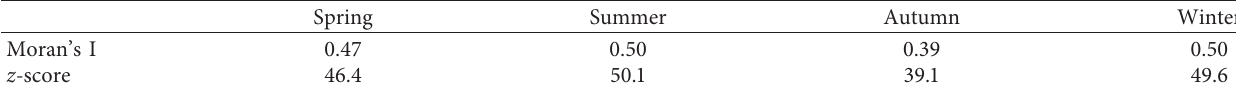
Early- N is short for early night, and Early- M is short for early morning. Table 4: Moran’s I and the z -scores for the diurnal variation of precipitation in Figure 4. Spring